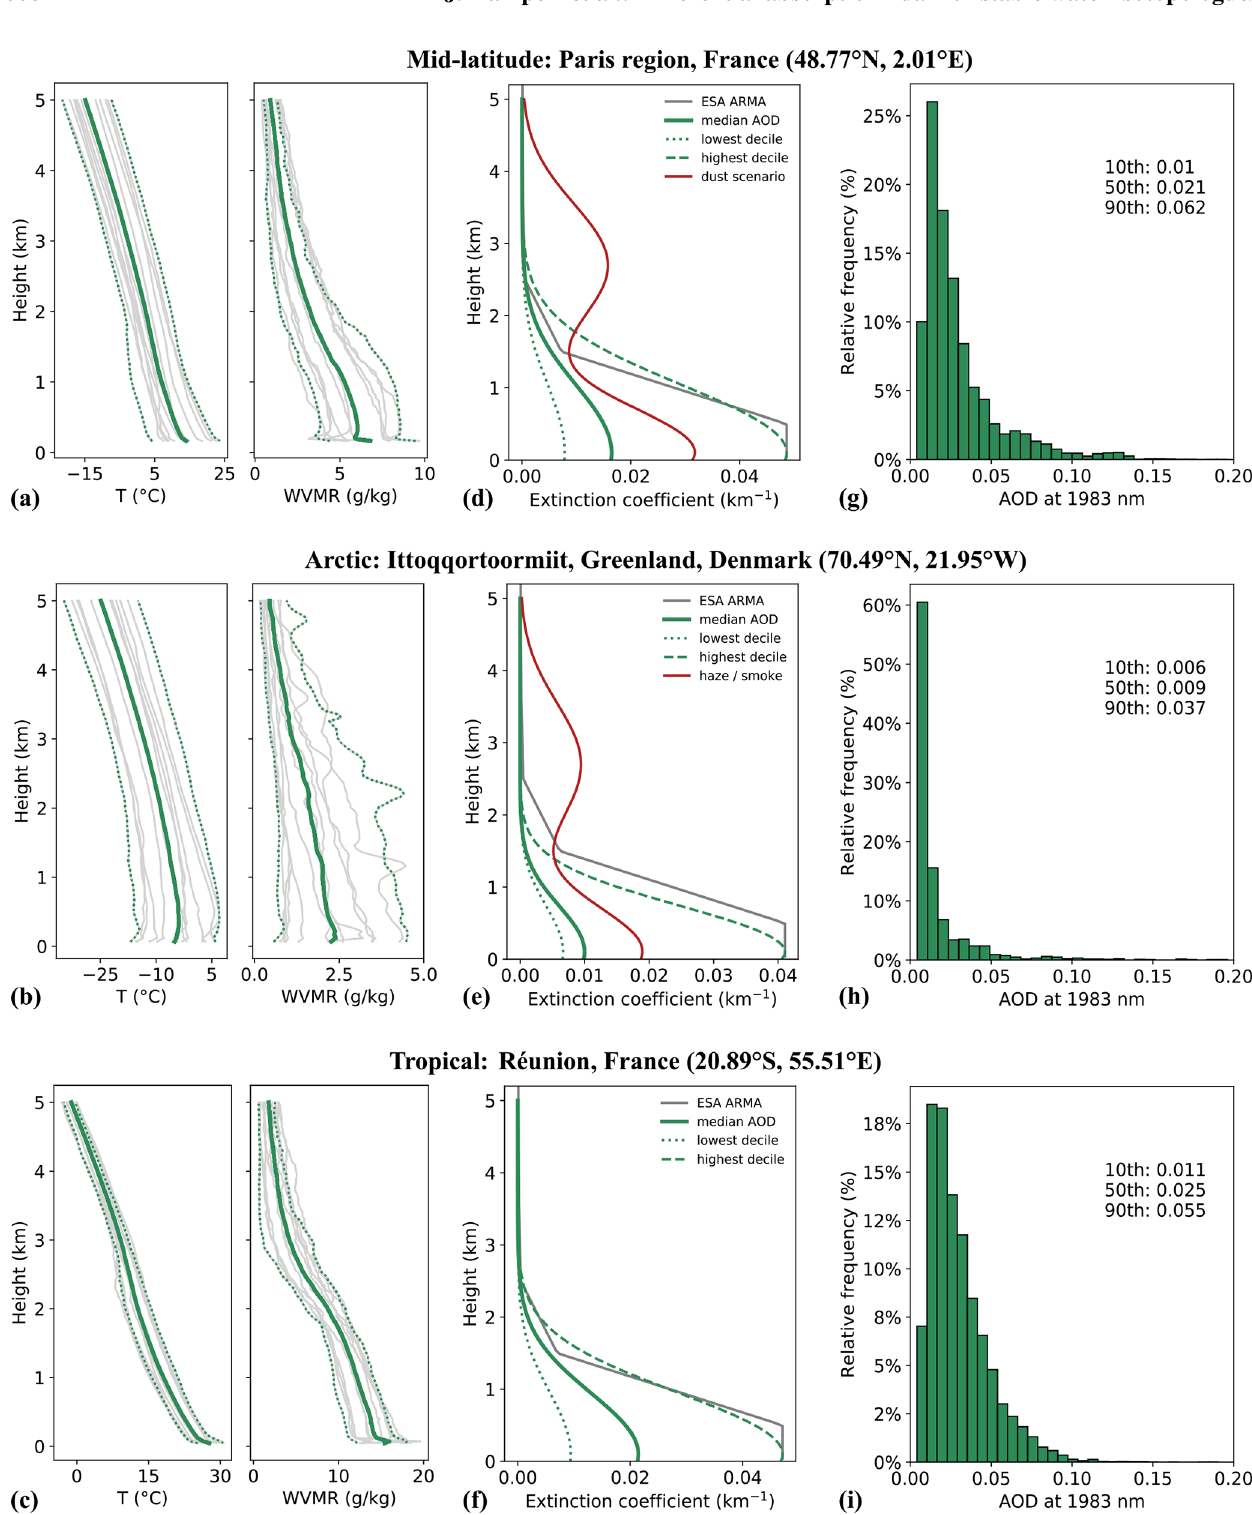
Figure 3. Atmosphere models: (a–c) vertical sounding profiles of temperature and the water vapor mixing ratio (WVMR). Grey lines indicate monthly averages; solid green line is the yearly average of 2019 (baseline profile). Dotted lines indicate profiles of the lowest and highest monthly temperatures and WVMR; (d–f) model profiles of aerosol extinction coefficient; (g–i) distribution of the aerosol optical depth at 1983nm for AERONET level 2.0 data of